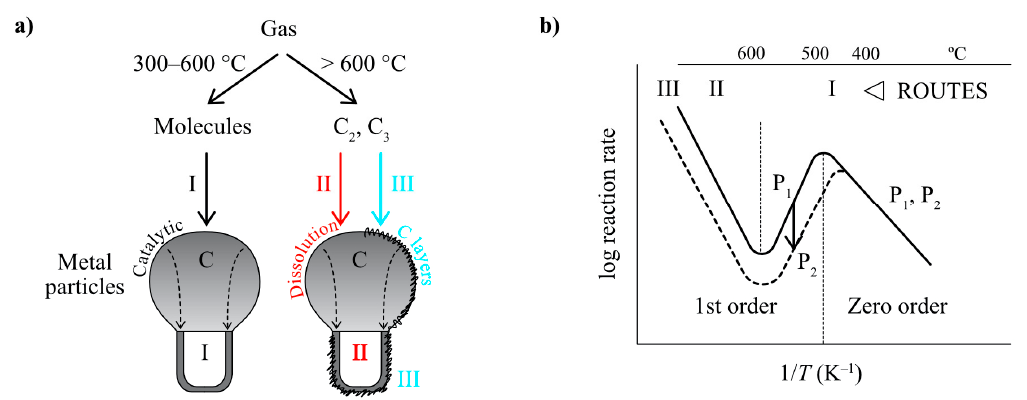
Figure 1. ( a ) Three kinetic routes key points: I − Surface catalysis; II − C dissolution; III − C layers; ( b ) Typical Arrhenius plots observed experimentally with Ni, Co and Fe over a wide T range.